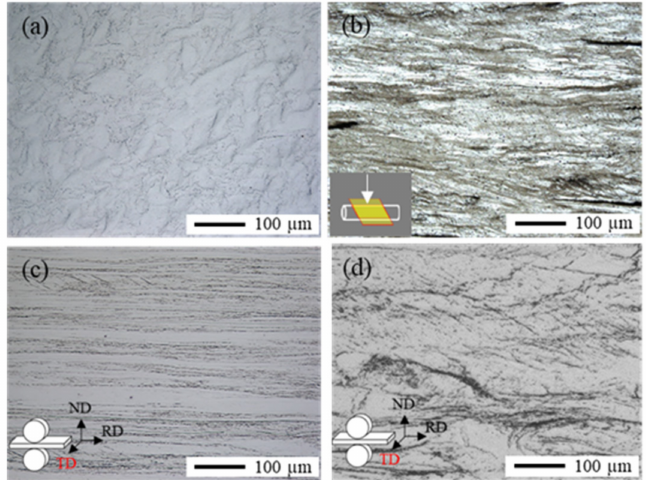
Figure 3. Microstructures obtained from ( a ) as-received NbTi billet, ( b ) ECAPed specimen with strain 2.0 [16], ( c ) hot rolled specimen with strain 0.7 [17] and ( d ) hot rolled specimen with strain